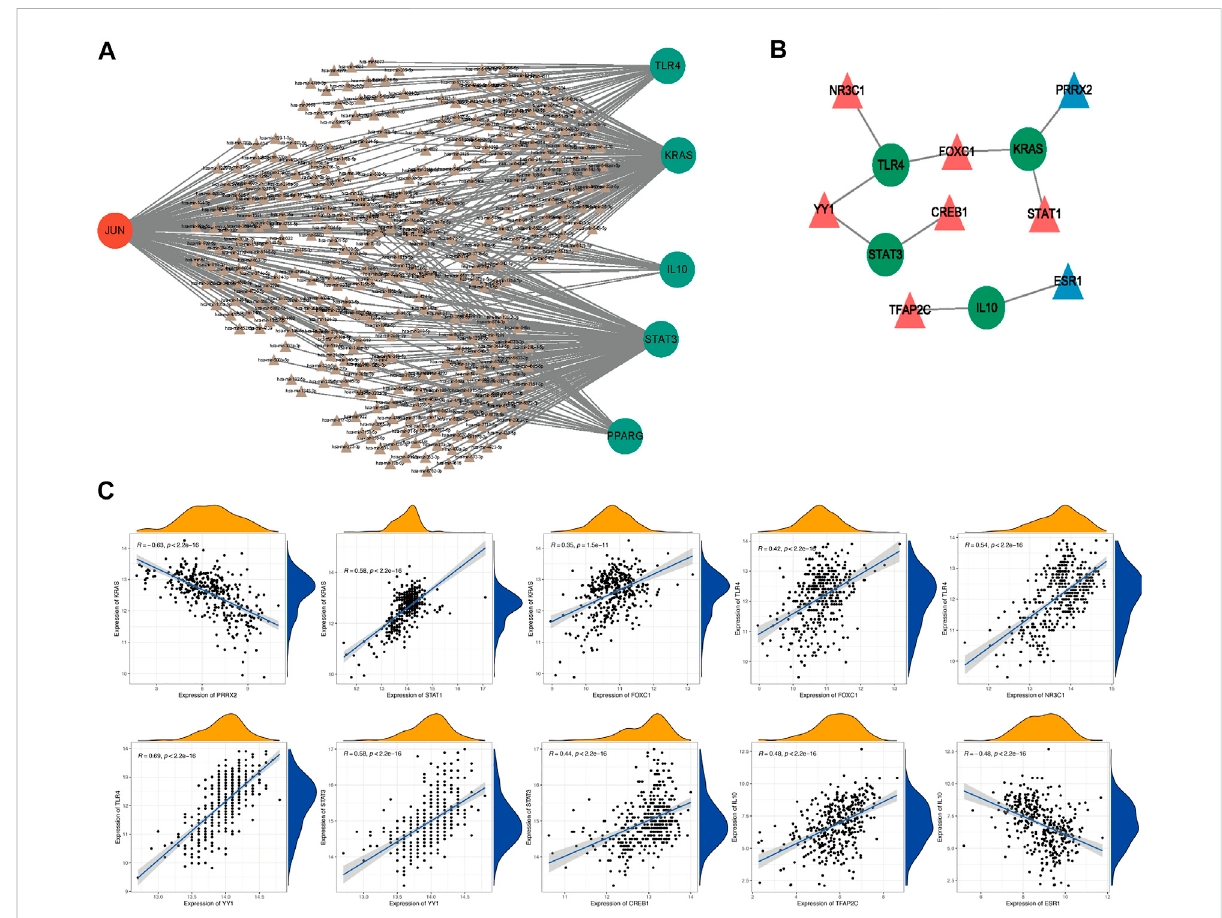
FIGURE 4 The potential regulatory mechanisms of ultimately hub genes. The regulatory relationships between the target genes and their miRNAs (A) . Green, downregulated; red, upregulated; Circle, hub gene; Triangle, miRNA. The interaction network consists of 4 hub genes and 8 TFs (B) . Blue, downregulated; red, upregulated; Circle, hub genes; Triangle, Transcription Factor. The correlation analysis of 4 hub genes and their potential TFs (C)